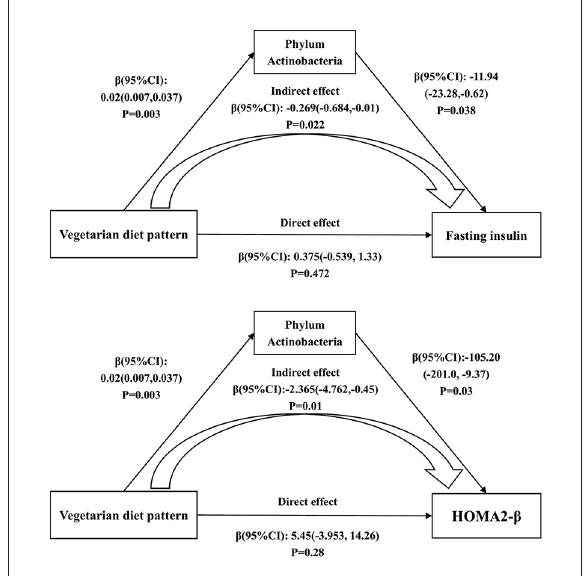
FIGURE5 The mediating effects of phylum Actinobacteria on the associations of the vegetarian diet pattern score with fasting insulin and HOMA2- β . Adjusted for age, gender, education level, marriage, income, smoking, alcohol consumption and physical